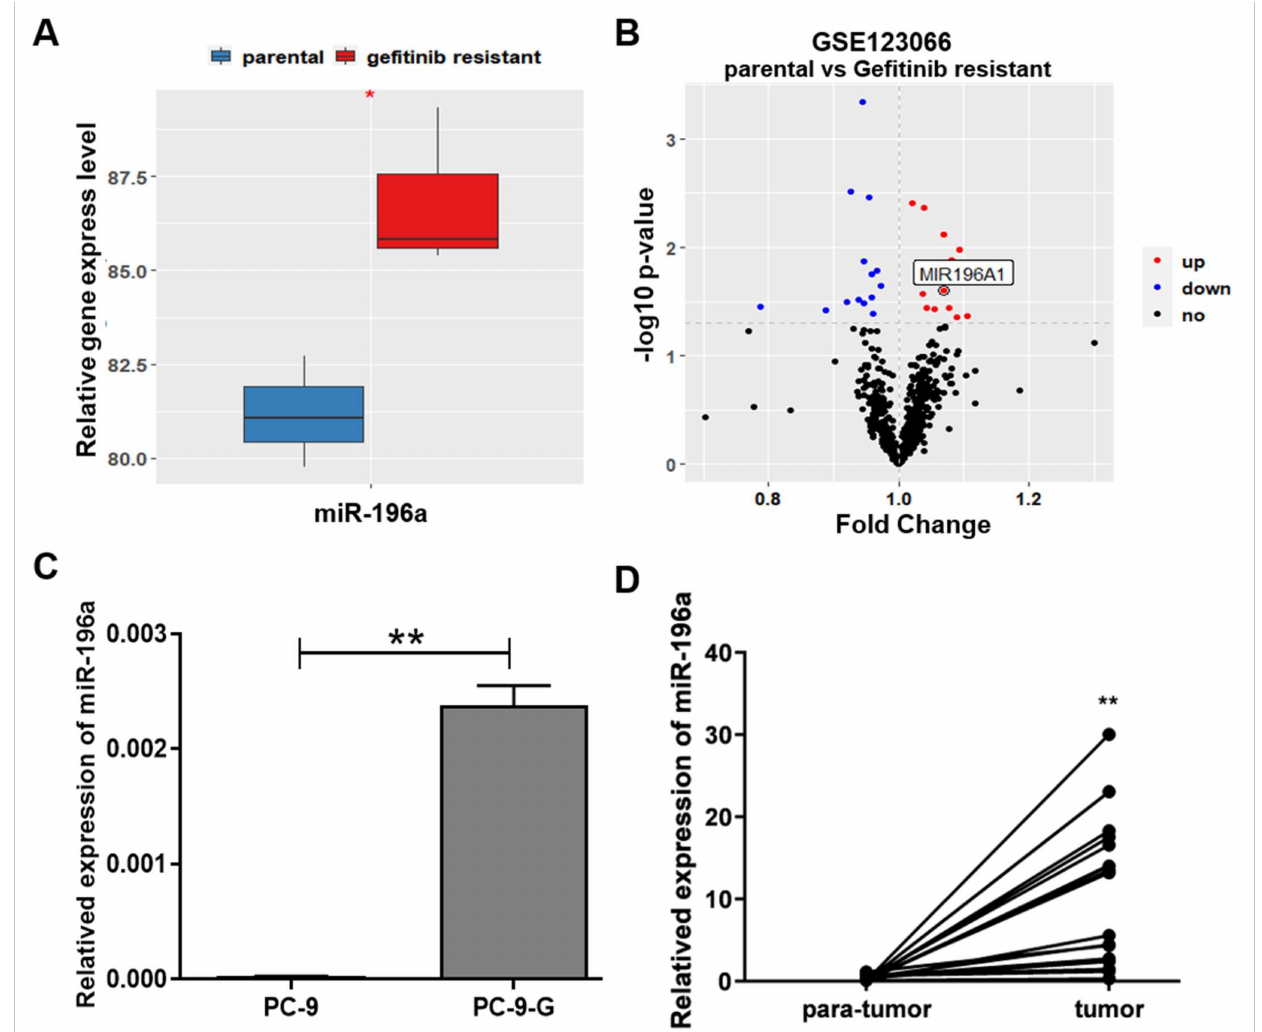
Figure 1. miR-196a levels were upregulated in the gefitinib-resistant lung cancer cells and were correlated with lung cancer patient survival. ( A ) The relative gene expression levels of miR-196a were examined in the parental and gefitinib-resistant lung cancer cells in GEO database. ( B ) The gene expression levels were analyzed in GSE123066 database by Volcano plot, red dots represent high expression levels in the gefitinib-resistant group compared to parental group. ( C ) The miR-196a mRNA levels were measured in PC-9 and PC-9-G cells by qRT-PCR. ( D ) The two connected dots represent the miR-196a levels in the tumors and corresponding adjacent tissues from the same patients (n = 17). Data represent the mean ± S.D. of 3 independent experiments where * indicates significant difference at p < 0.05, ** indicates at p <